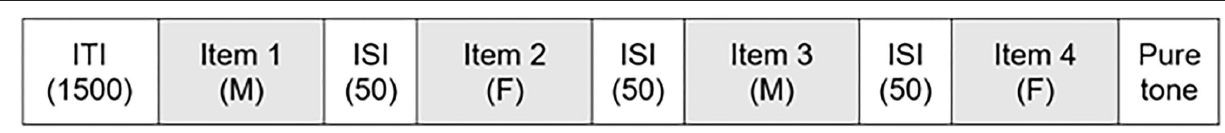
FIGURE 2 | Composition of each trial of the four-item sequence-recall task. The numbers in parentheses are the duration of each interval in milliseconds; the letter M and F in the parentheses stand for male and female speakers,